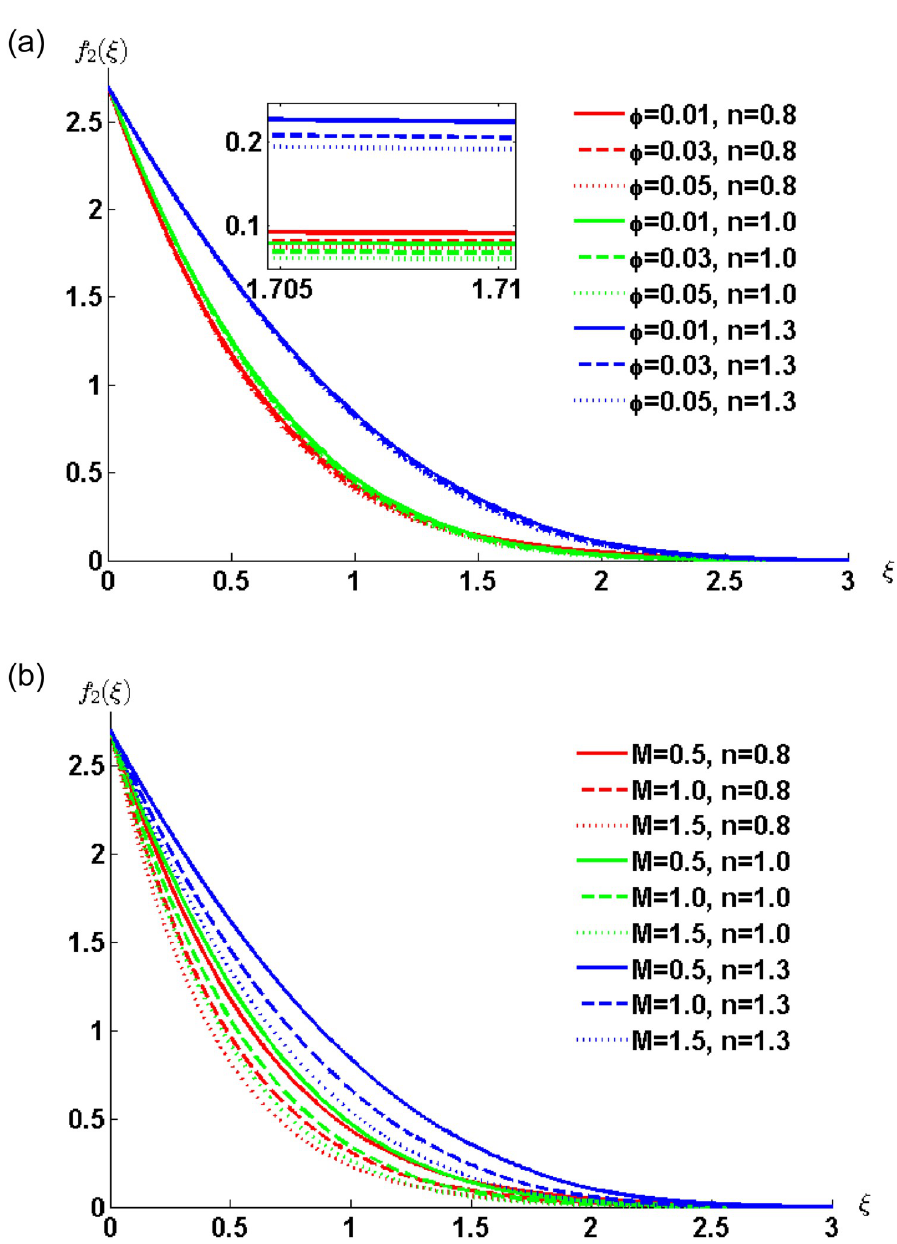
Fig 7. Velocity profile for various values of φ , and M when ρ s = 8933, ρ f = 997.1 σ s = 5.5 × 10 − 6 and σ f = 5.96 × 10 7 are fixed.